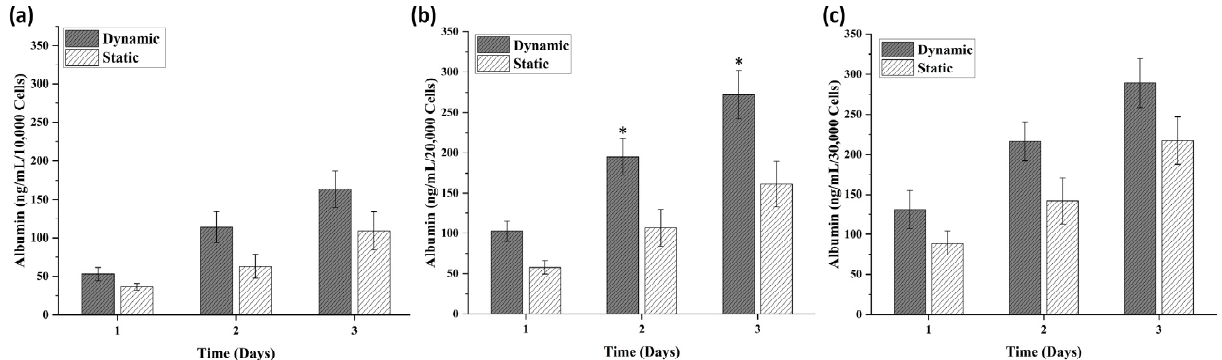
Figure 5. Static vs. dynamic culture albumin molecular biomarker analysis; ( a ) albumin secretion in spheroid with 10,000 cells; ( b ) albumin secretion in spheroid with 20,000 cells; ( c ) albumin secretion in spheroid with 30,000 cells. * p ≤ 0.05 for dynamic versus static culture conditions.